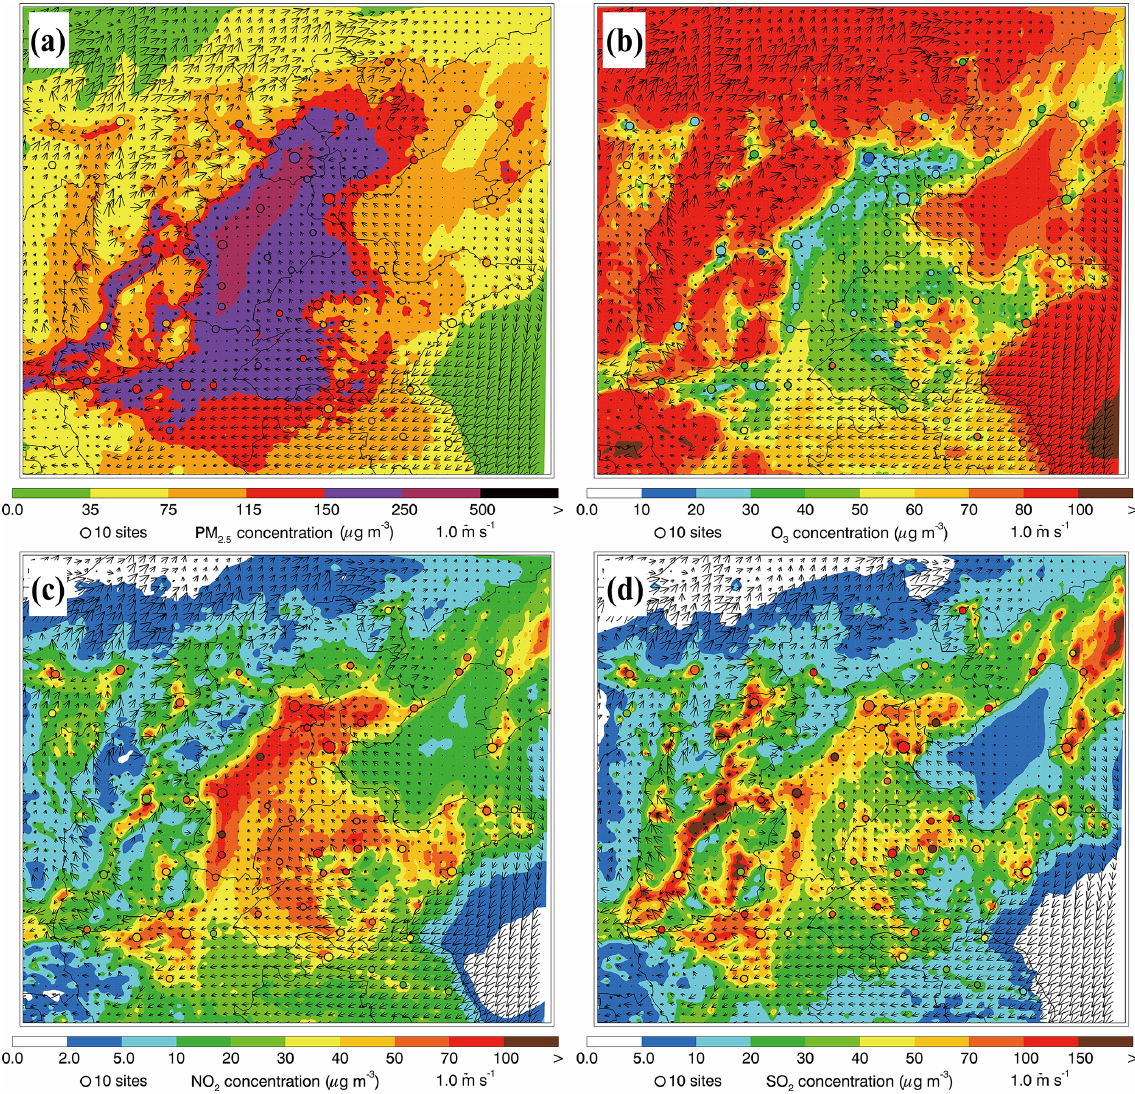
Figure 6. Spatial distributions of average (a) PM 2 . 5 , (b) O 3 , (c) NO 2 , and (d) SO 2 mass concentrations from 10 to 27 February 2014. Colored dots, colored contour, and black arrows are observations, simulations, and simulated surface winds,